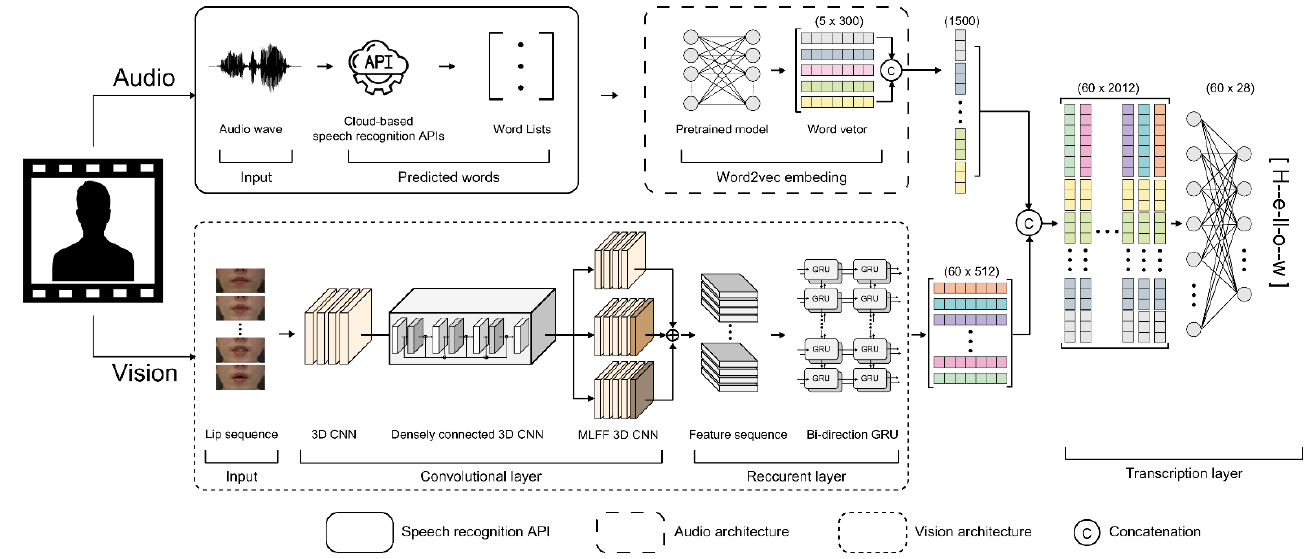
Figure 2. Block diagram of proposed audio-visual speech recognition system.